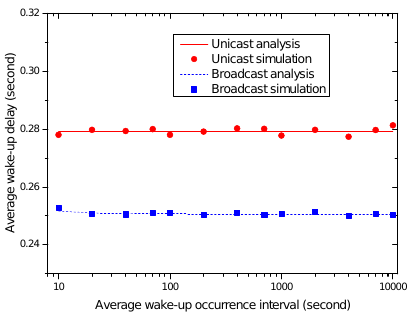
Figure 15. The wake-up delays of two wake-up mechanisms.